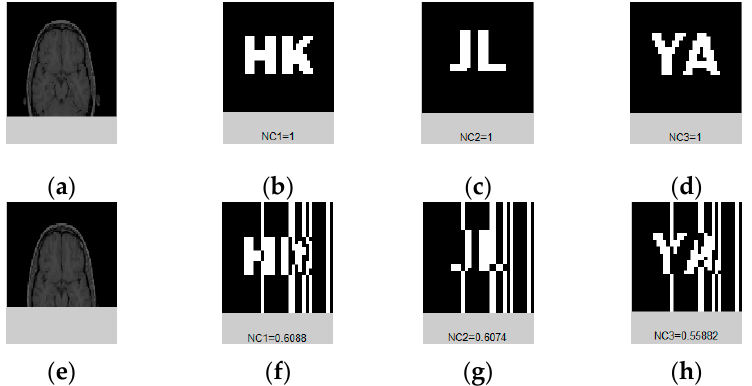
Figure 22. Under cropping attacks: (a) Cropping 23%, Y direction; (b) the extracted watermark 1 under 23% cropping; (c) the extracted watermark 2 under 23% cropping; (d) the extracted watermark 3 under 23% cropping; (e) Cropping 37%, Y direction; (f) the extracted watermark 1 under 37% cropping; (g) the extracted watermark 2 under 37% cropping; (h) the extracted watermark 3 under 37% cropping. Table 10. Data of cropping attacks.